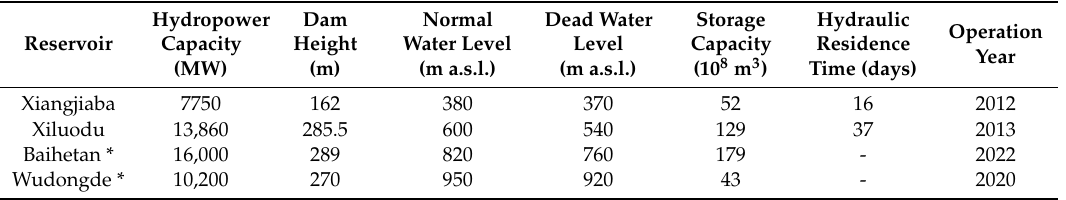
Table 1. Main features of the cascading hydroelectric reservoirs in the lower reaches of Jinsha River (* denotes dams under construction). Dead water level refers to the lowest water level that allows the reservoir to operate under normal